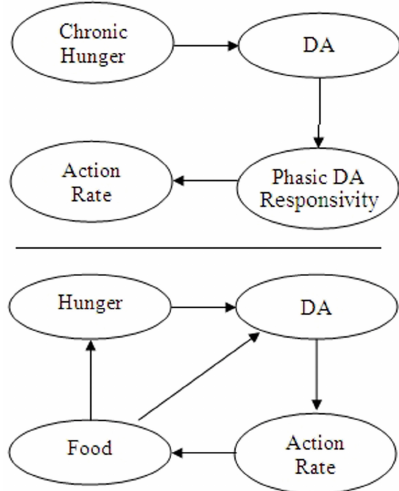
Figure 1. Top: Chronic hunger results in a decrease in the amount of extra-cellular dopamine. This triggers the homeostatic mechanism, which increases the respon- siveness of the phasic dopamine system. This results in a more vigorous dopamine- related response. Bottom: Action rate is directly proportional to the dopamine